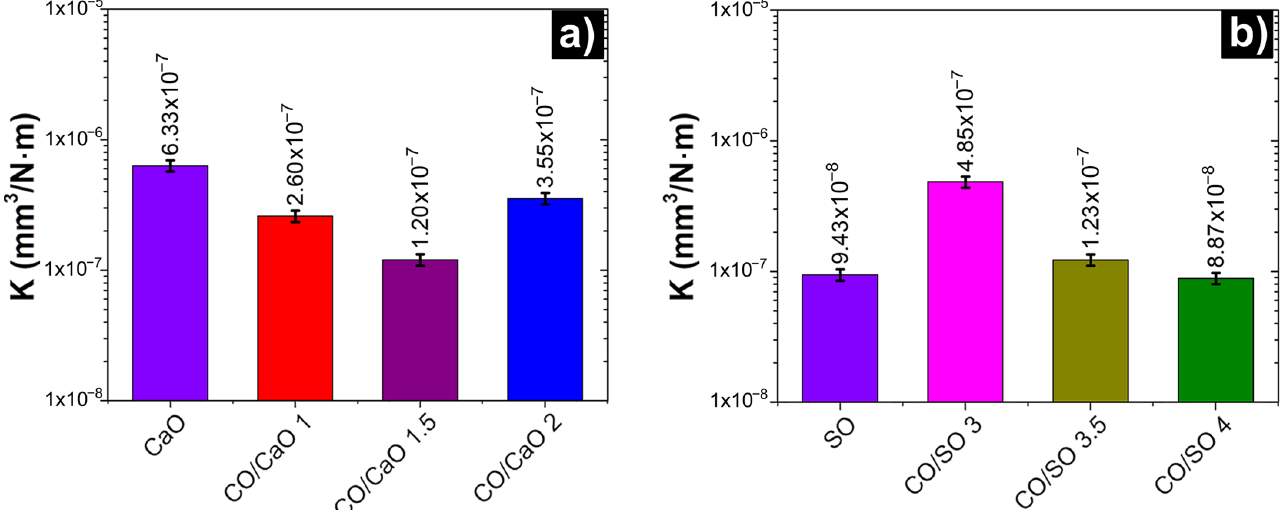
Figure 7. SEM and EDS analysis on the worn surface of AISI 8620 steel lubricated with canola oil.